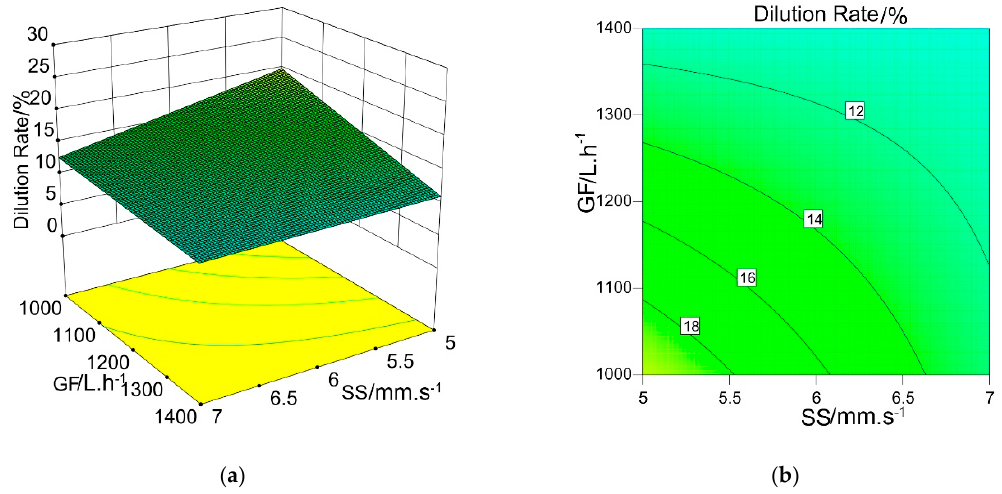
Figure 15. ( a ) 3D response surface showing the influence of scanning speed and gas flow on dilution rate. ( b ) Contour line of the response surface.